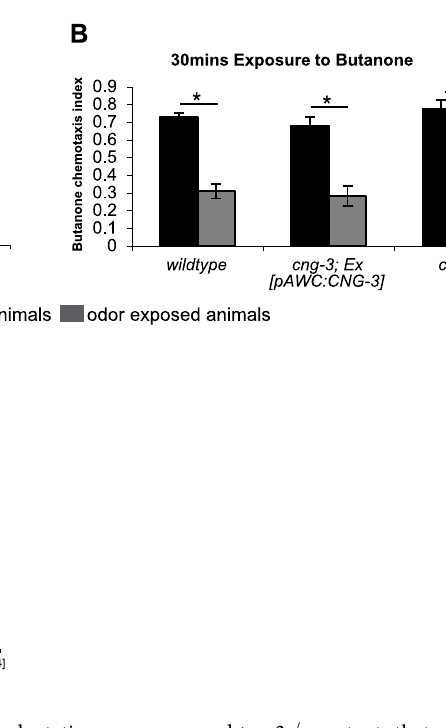
5 Scientific RepoRts | 7: 169 | DOI:10.1038/s41598-017-00126-7